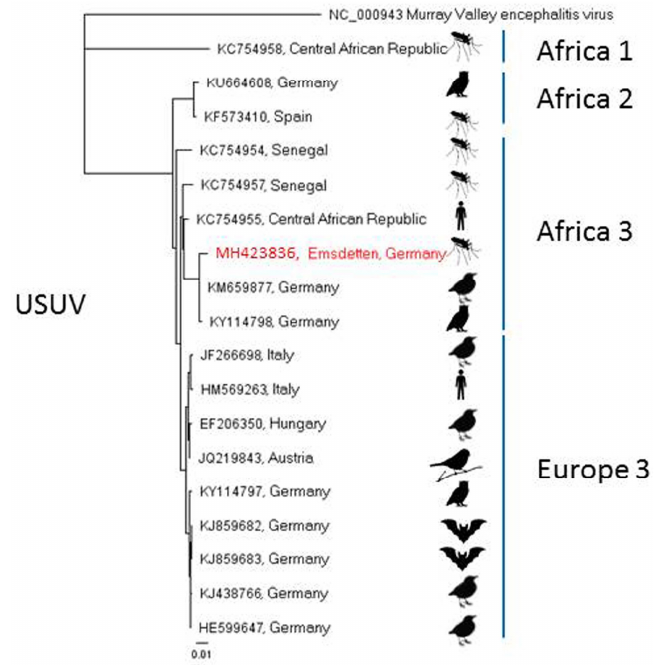
Figure 4. Phylogenetic tree of USUV sequences based on 1828 nucleotides of the NS5 protein. Red text marks sample of this